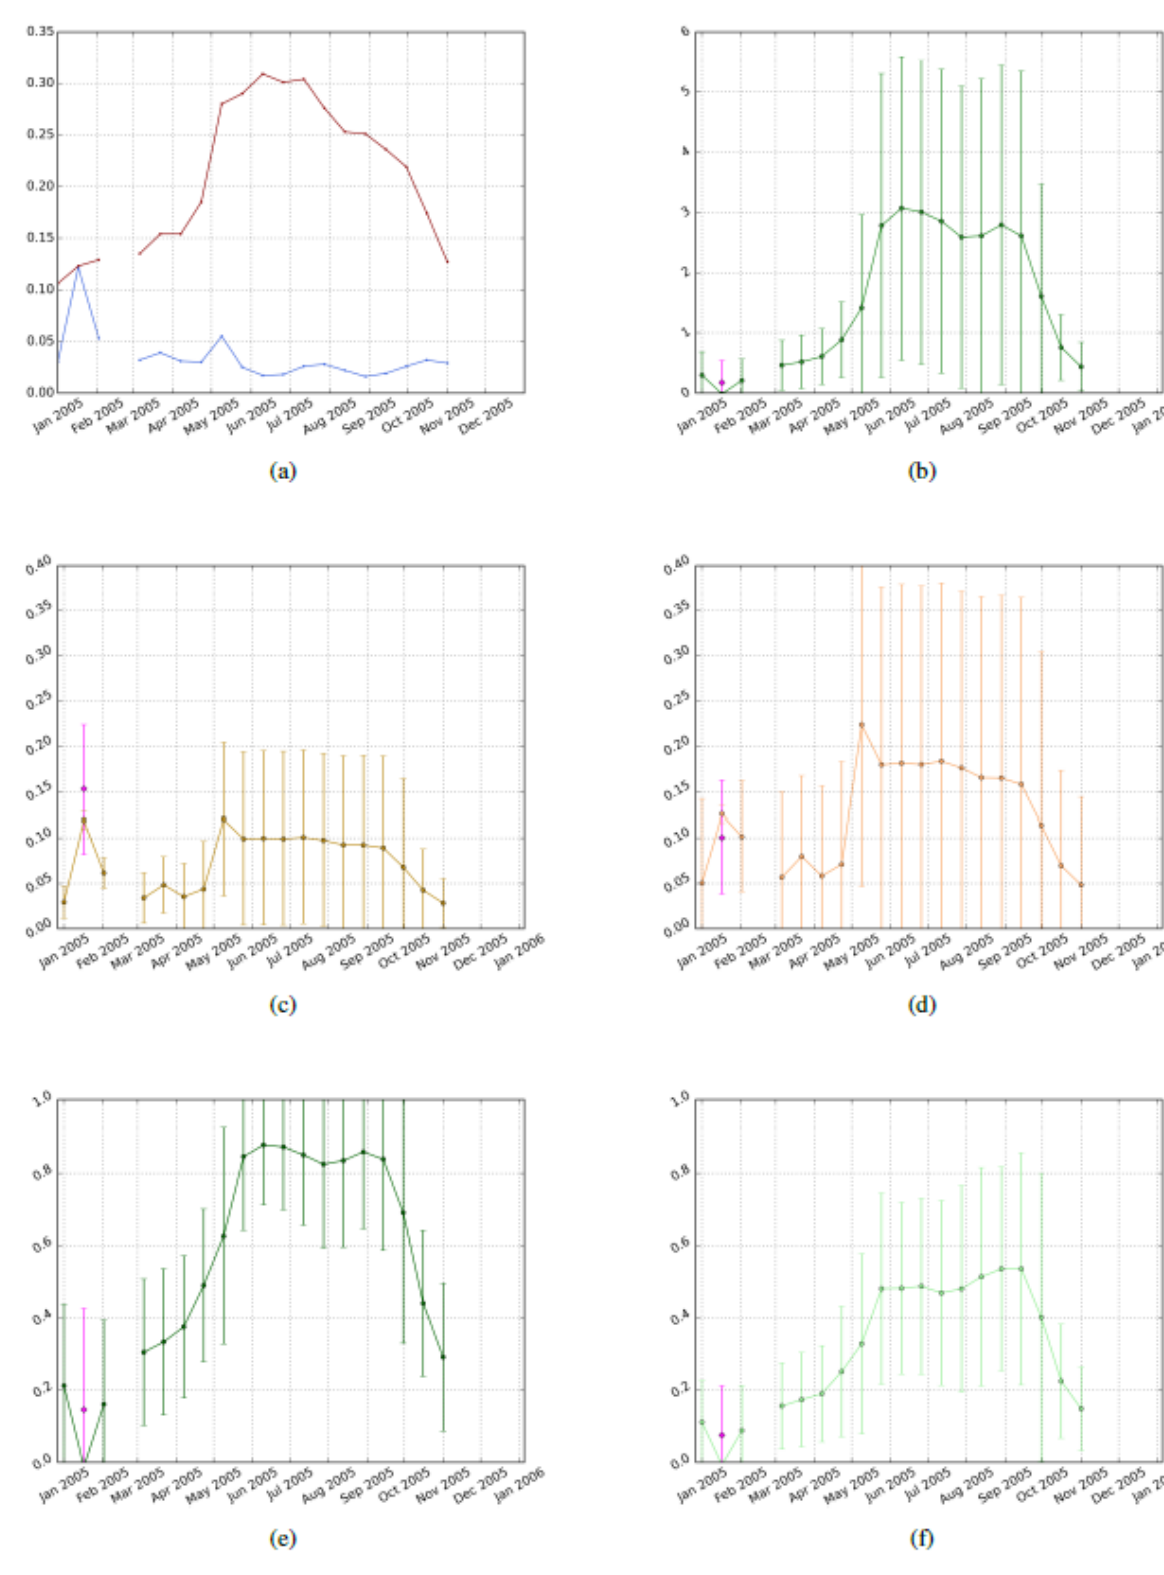
Figure 9. MCD43 500m input albedos over the pixel covering the 400m transect in the visible and near-infrared domains (a) , retrieved effective LAI (b) , background reflectance VIS (c) and NIR (d) , and fluxes absorbed in the vegetation in VIS (e) and NIR (f) . Additional snow prior retrieval in panels (b–f) in